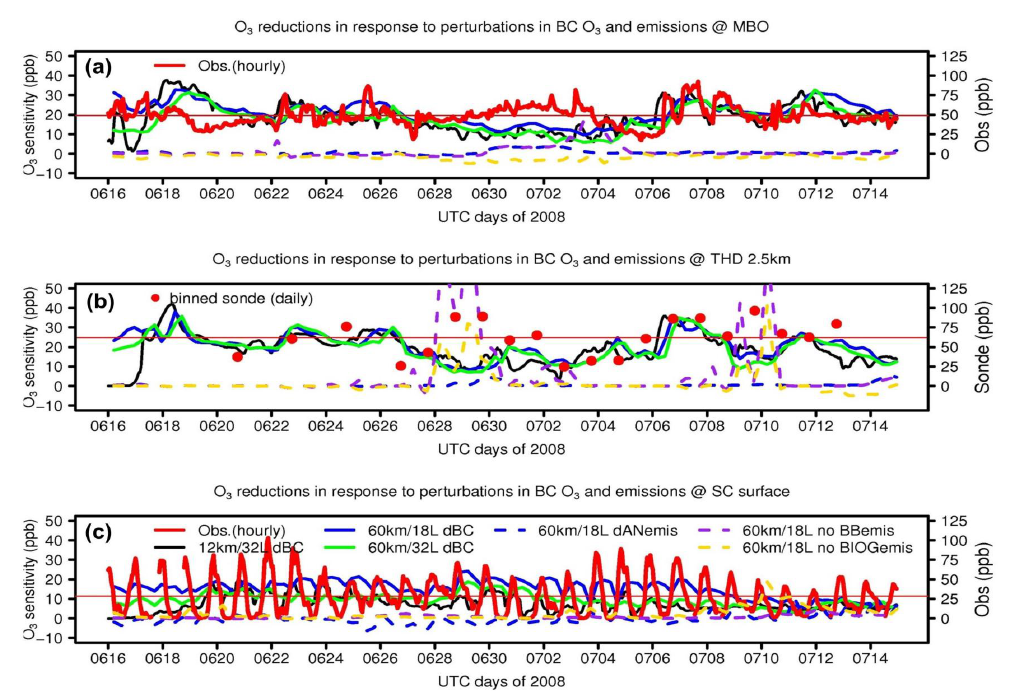
Fig. 8. Time series of O 3 reductions at (a) MBO 2.7kma.s.l.; (b) THD 2.5kma.s.l.; and (c) SC lowest level, in response to 50% perturbations in O 3 boundary conditions (dBC), reduction in US anthropogenic emissions (dANemis) and zeroing out the North American biomass burning (BBemis) and biogenic emissions (BIOGemis). Time series of observations at the corresponding altitude and their period mean are drawn as the red thick and horizontal thin lines,